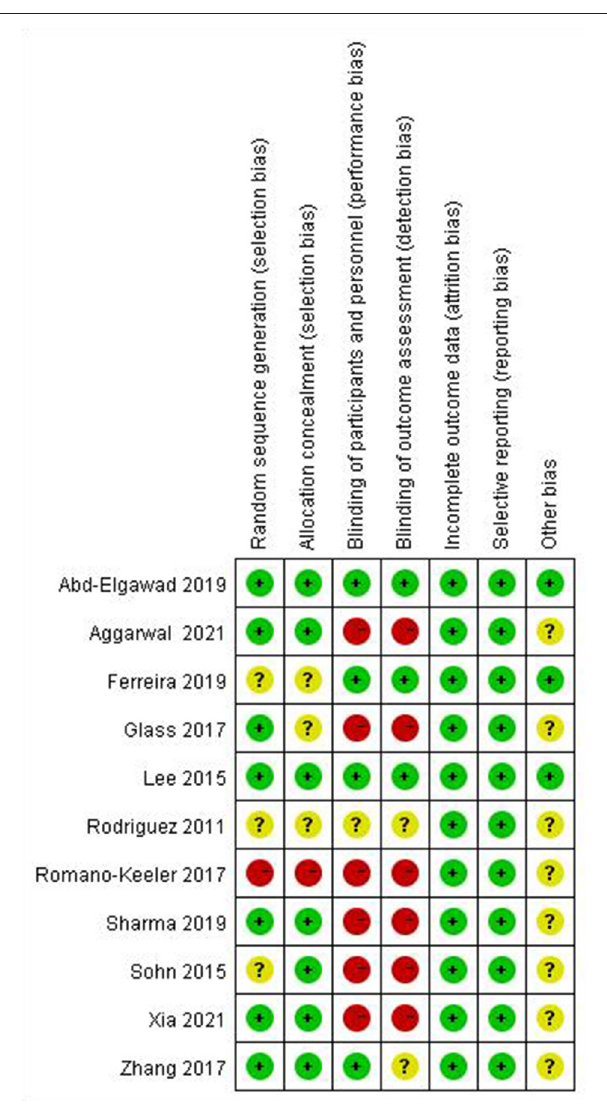
FIGURE 2 | Summary of risk of